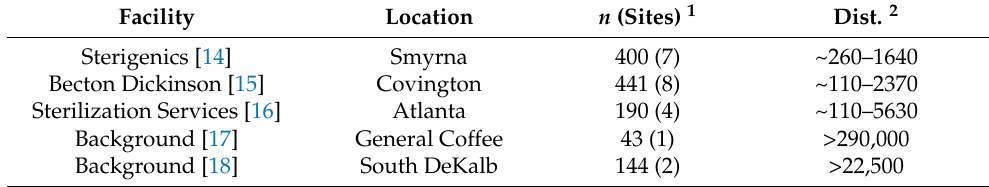
Table 1. Summary of publicly available datasets concerning measurement of ambient air EO concen- trations in Georgia in the vicinity of three sterilization facilities and at background locations.